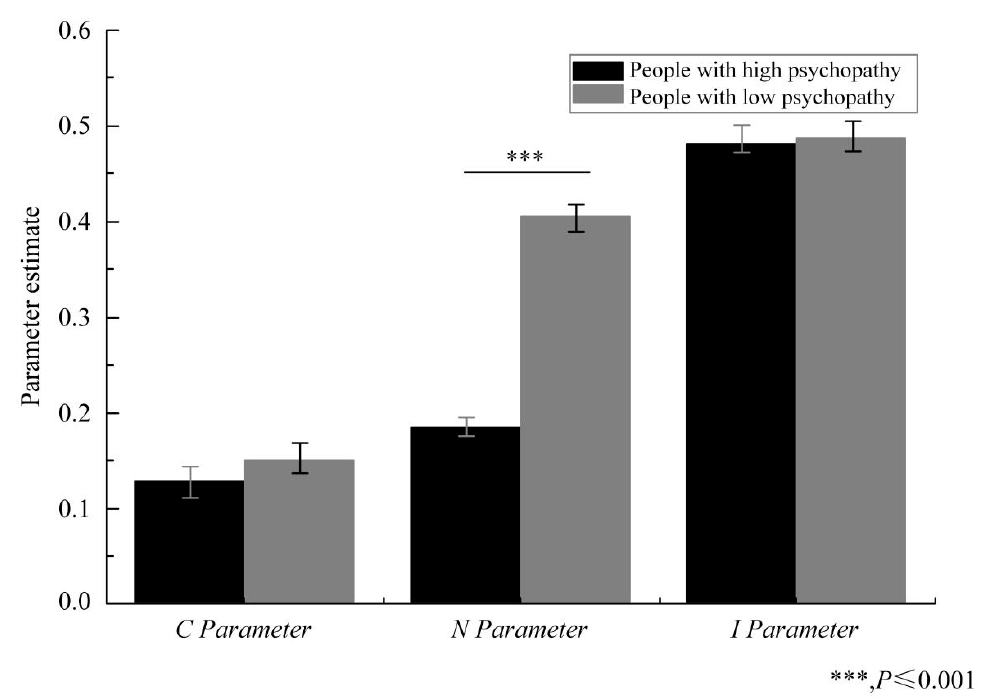
Figure 2. The CNI model’s high and low psychopathy groups’ parameter estimates for sensitivity to moral consequences ( C ), sensitivity to moral norms ( N ), and the general preference for inaction versus action ( I ).